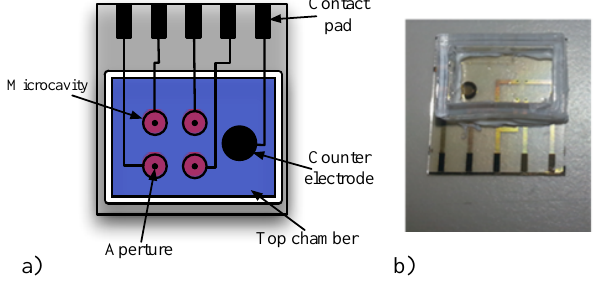
Figure 4. ( a ) Diagram showing the microfluidic device. The counter electrode sets the potential of the top fluid chamber, which is common to every BLM. There are four separate microcavities each with individual bilayers and separate integrated Ag/AgCl electrodes; ( b ) A photograph of the microfluidic device.